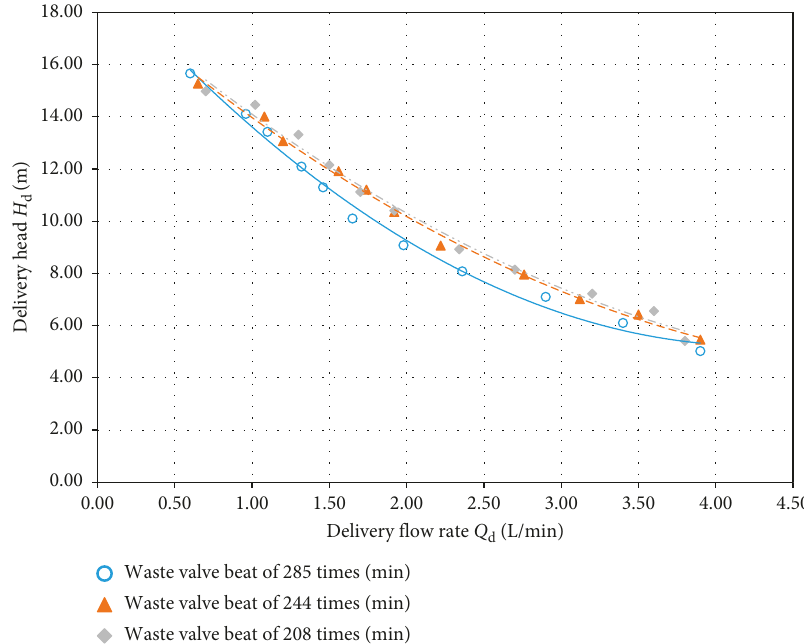
Figure 12: Delivery head vs. delivery flow rate at different waste valve beat rates, f